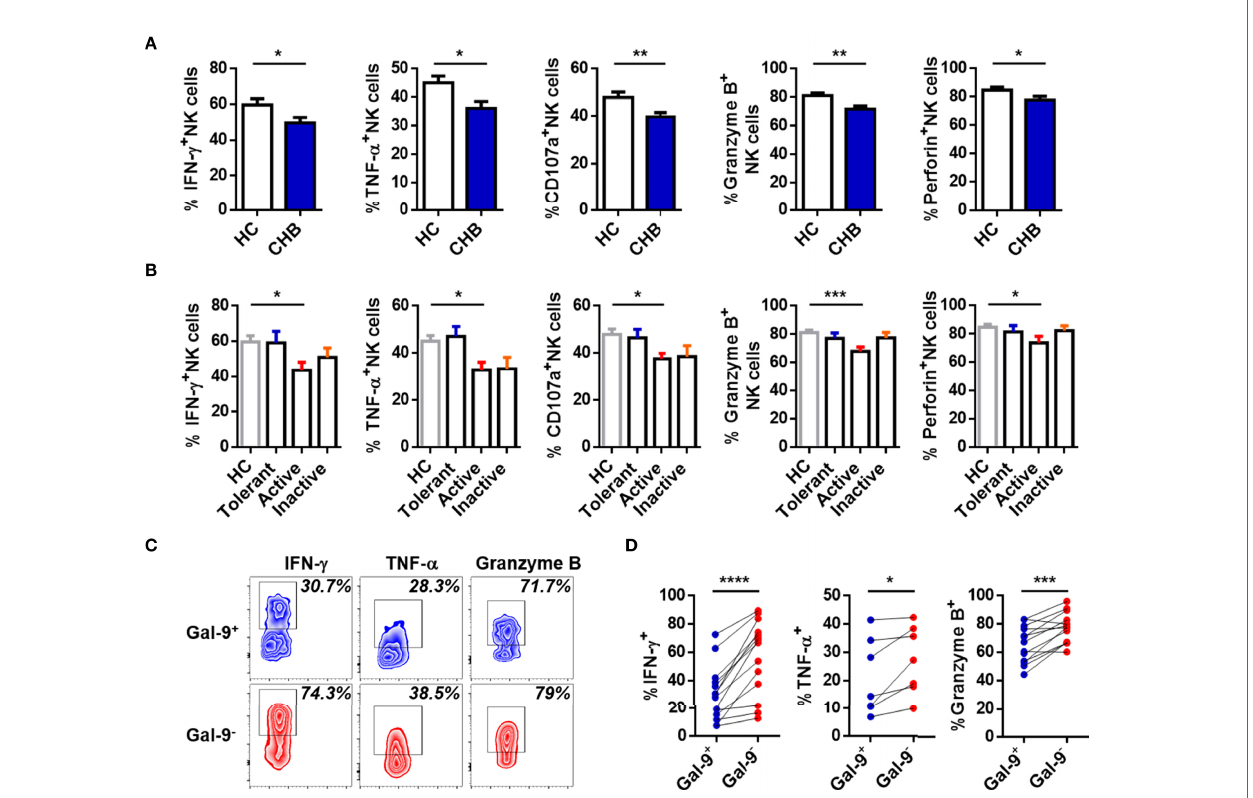
FIGURE 2 | Gal-9 + NK cells are impaired relative to Gal-9 - NK cells in CHB patients. (A) Comparison of the expression of IFN- g , TNF- a , CD107a, granzyme B, and perforin in circulating NK cells from CHB patients and HCs. (B) Comparison of the expression of IFN- g , TNF- a , CD107a, granzyme B, and perforin in circulating NK cells from Tolerant, Active, and Inactive CHB patients and HCs. (C) Representative fl ow cytometry plots showing the expression of IFN- g , TNF- a , and granzyme B in circulating Gal-9 + NK cells and Gal-9 - NK cells from CHB patients. (D) Comparison of the percentages of IFN- g , TNF- a , and granzyme B secreted by Gal-9 + NK cells and Gal-9 - NK cells in peripheral blood from CHB patients. Results are expressed as the mean ± SEM, and the number of samples (n) in each group was ≥ 3. One-way ANOVA test was conducted for four-group comparisons. Groups with signi fi cant differences are marked, and the unmarked paired groups have no differences. An unpaired t-test was used to compare two independent groups. A paired t-test was used to compare paired samples. *P < 0.05; **P < 0.01; ***P < 0.001; ****P <